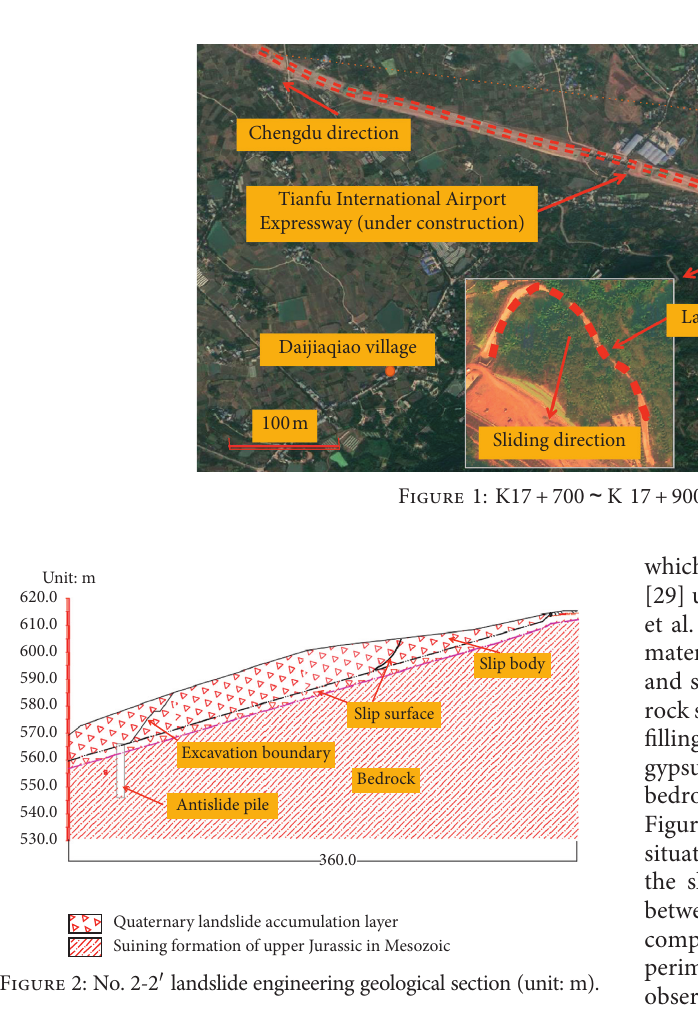
The supporting structure was damaged.